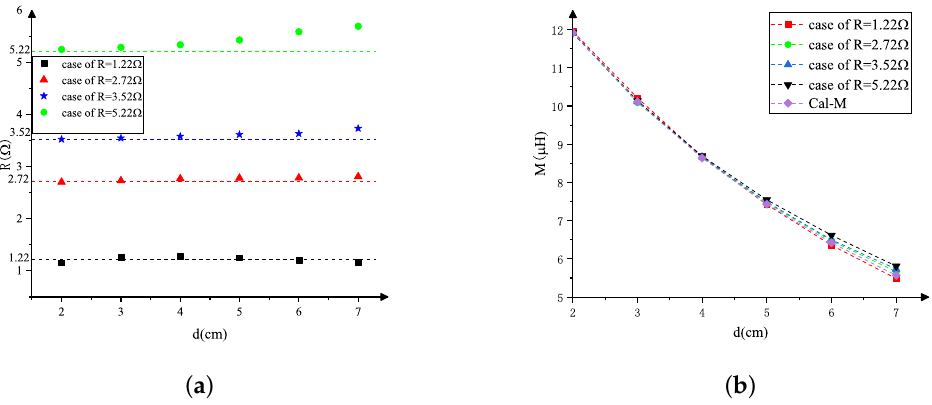
Figure 8. Calculation result of load resistance and mutual inductance. ( a ) Load resistance; ( b ) mutual